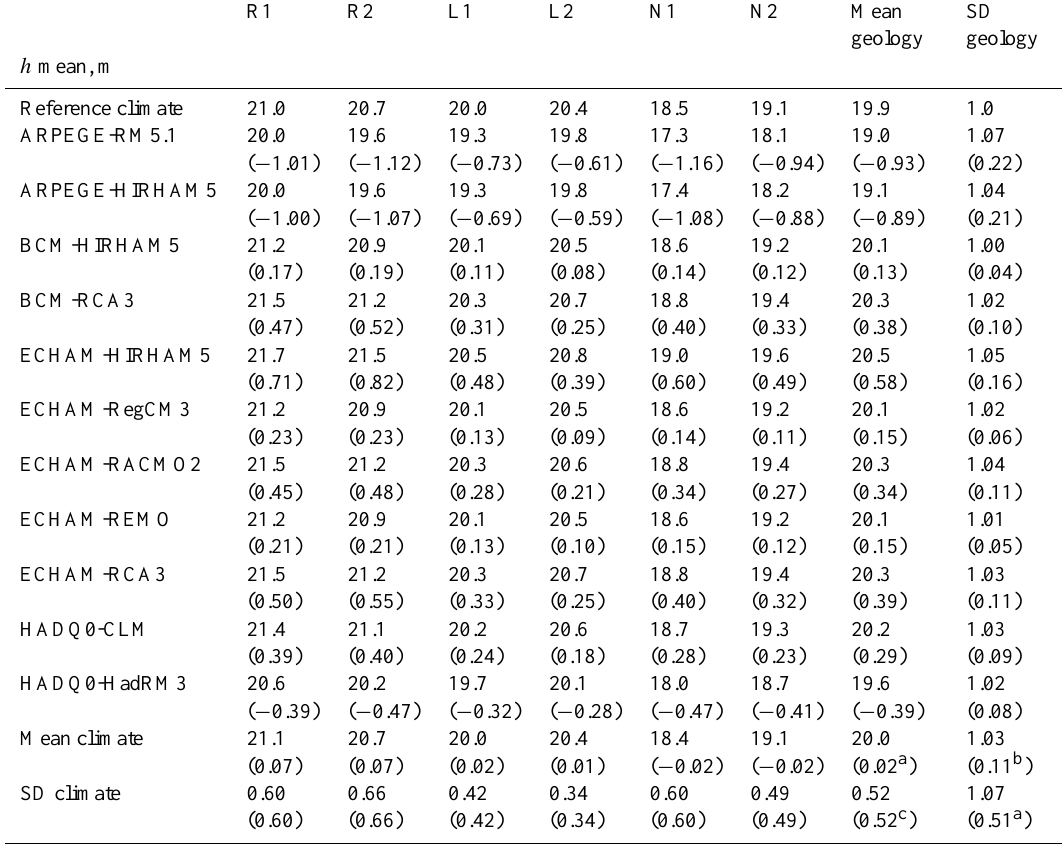
Table 3. Simulated mean hydraulic head in the limestone aquifer in the focus area for the reference scenario and the scenario climates. Changes in mean hydraulic head from reference to scenario climate are listed in brackets. “Mean geology” and “SD geology” are the average and the standard deviation of the results from the hydrological models for each climate scenario. “Mean climate” and “SD climate” the average and the standard deviation of the results from the different climate models used in each hydrological